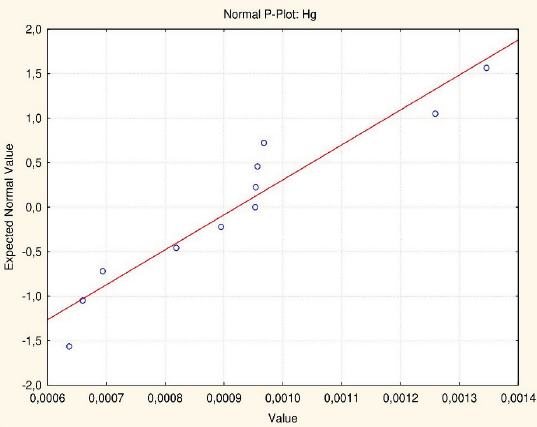
Different letters correspond to statistically different content of metals. Uppercase and lowercase letters correspond to significance level at